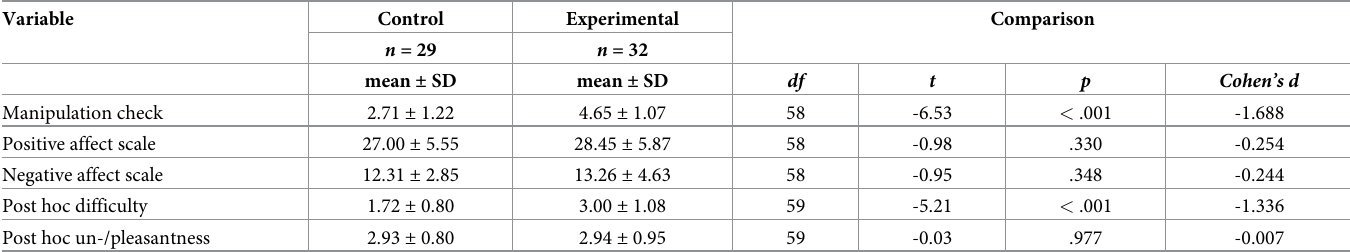
Table 3. Manipulation and mood